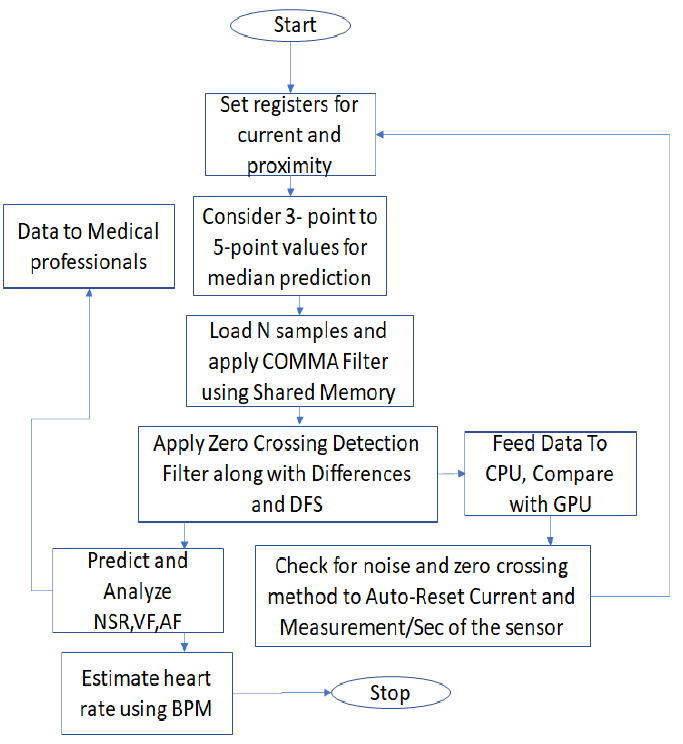
Figure 7. Software Algorithm Flowchart.